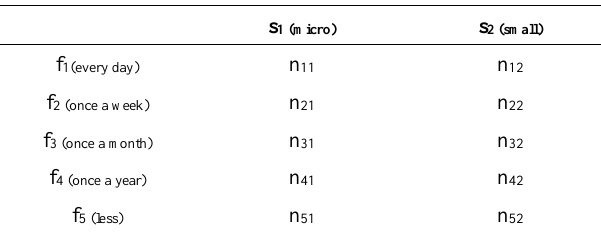
Table 2. Matrix of expected value